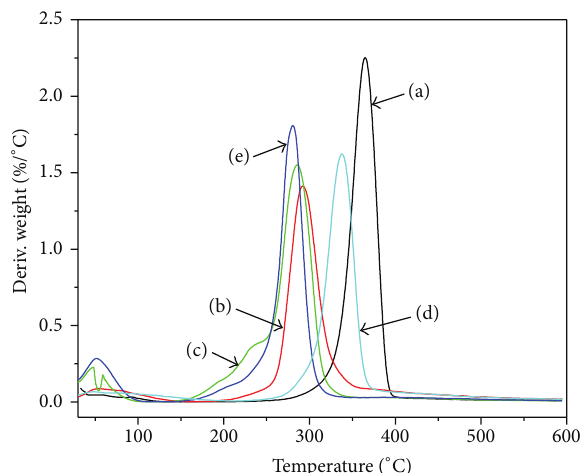
Figure 8: Strength of films, (a) AmimCl, (b) BmimCl, (c) EmimCl, and (d)